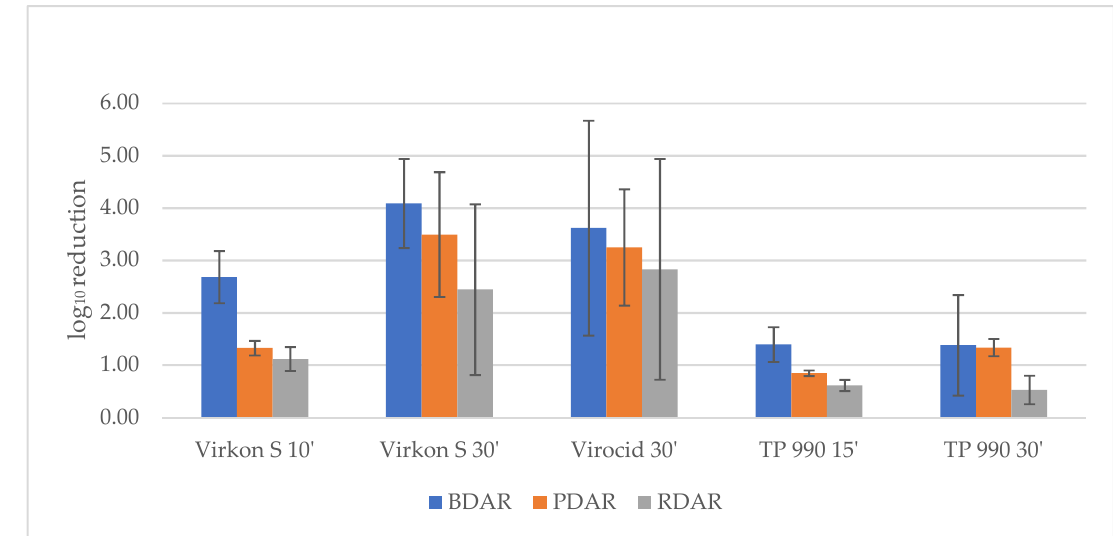
Figure 2. Morphological variation in disinfectant tolerance . The effect on RDAR, BDAR, and PDAR biofilm formed for two days and treated with Virkon S for 10 and 30 min, Virocid for 30 min, and TP990 for 15 and 30 min. Bars indicate standard deviation. ′ = Minutes of disinfectant exposure.